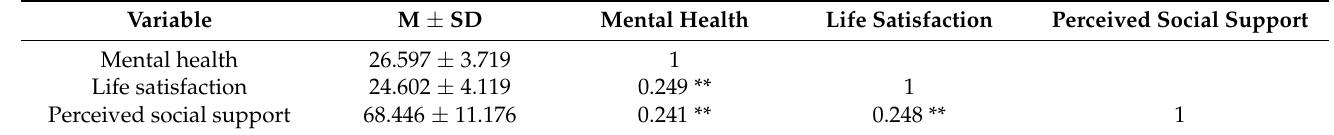
Table 2. Pearson correlation coefficients of main variables among the participants in Taian City, China,